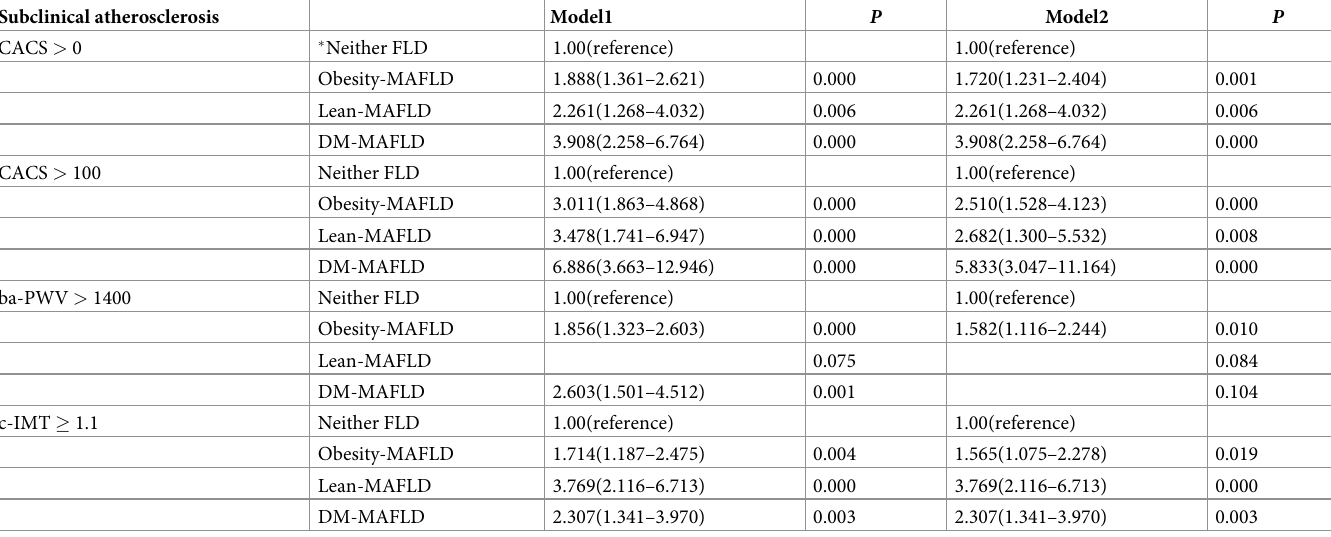
Table 5. The association of subclinical atherosclerosis with presence of any one of MAFLD groups. Subclinical